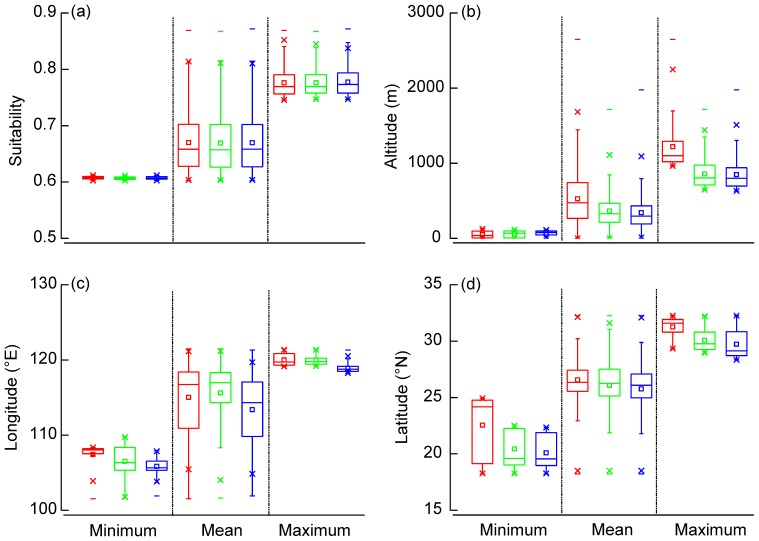
Discrepancy of suitability, altitude, longitude and latitude for predicted distribution between current and future scenarios.The minimum, mean, and maximum of suitability (a), altitude (b), longitude (c), and latitude (d) for predicted distribution of Gorsachius magnificus are exhibited. Red, green and blue represent current, A2a and B2a scenarios, respectively.